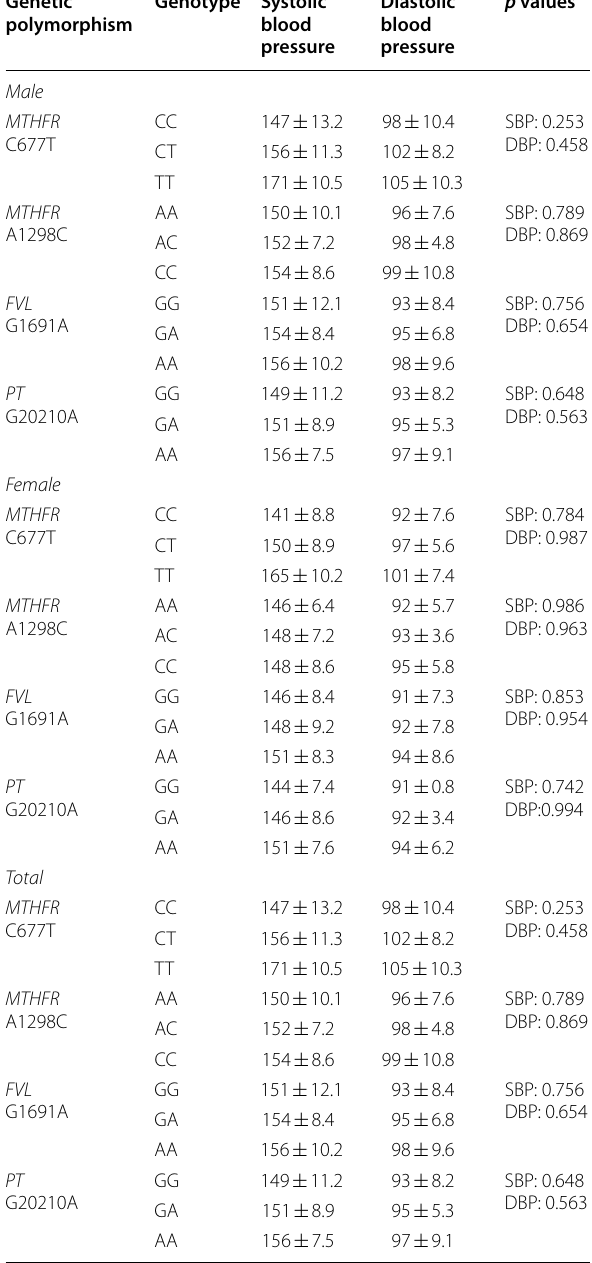
Results are shown as mean Systolic Blood Pressure: SBP Diastolic Blood Pressure: DBP